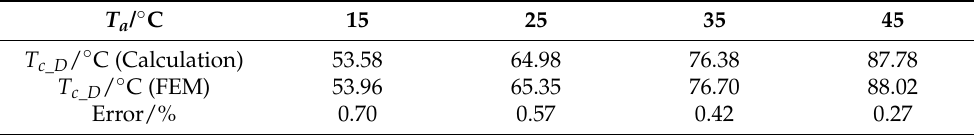
Table 7. The junction temperature comparisons of the calculation and simulation for the diode.